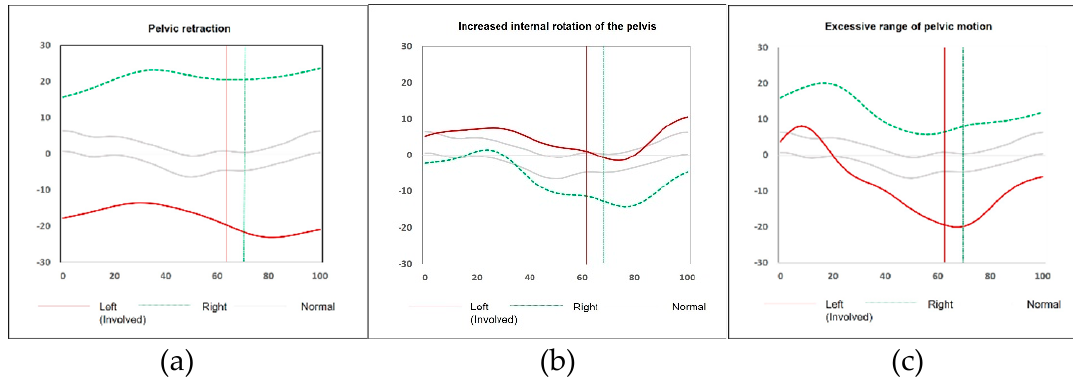
Figure 1. Demonstration of three types of pelvic rotation which may be seen in a patient with left hemiplegia. ( a ) Pelvic retraction: the average degree of external pelvic rotation on the left side (red line) is 15.64 ° , and the consistently increased external rotation of the pelvis throughout the gait cycle is more than two standard deviations from the norm. ( b ) Increased internal rotation of the pelvis compared to the contralateral right side (green line): the average degree of internal pelvic rotation on the left side is 4.91 ° which is within normal range. ( c ) Excessive range of pelvic motion: the average degree of external pelvic rotation on the left side is 6.05 ° ; however, increased internal rotation at early stance phase followed by a sinusoidal type of pelvic rotation are noted. Patients with an increased internal rotation of the pelvis or an excessive range of pelvic motion were excluded in this study.